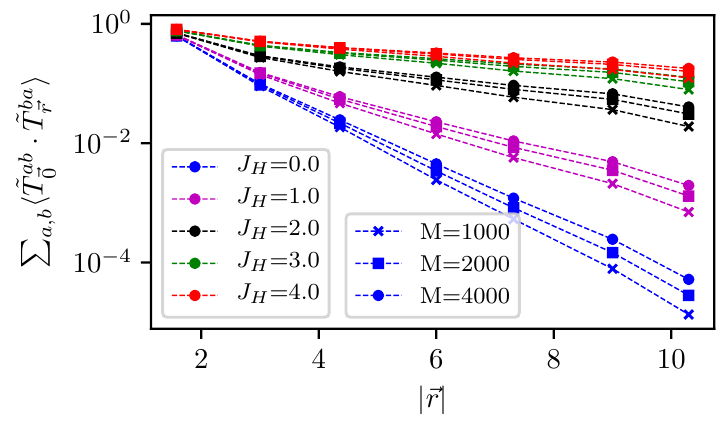
Figure 4: Flavor-flavor correlations obtained using DMRG and shown on a logarithmic scale for a cylinder of circumference N Different colors correspond to different values of J different markers to different bond dimensions M . For J correlations is consistent with an